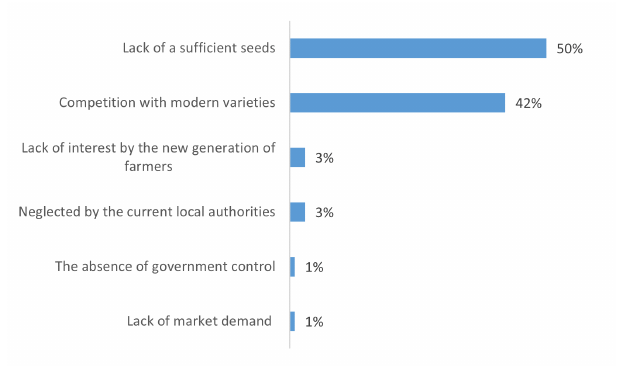
Figure 4. Reasons for farmers no longer cultivating crop landraces (based on the responses of 67 farmers).